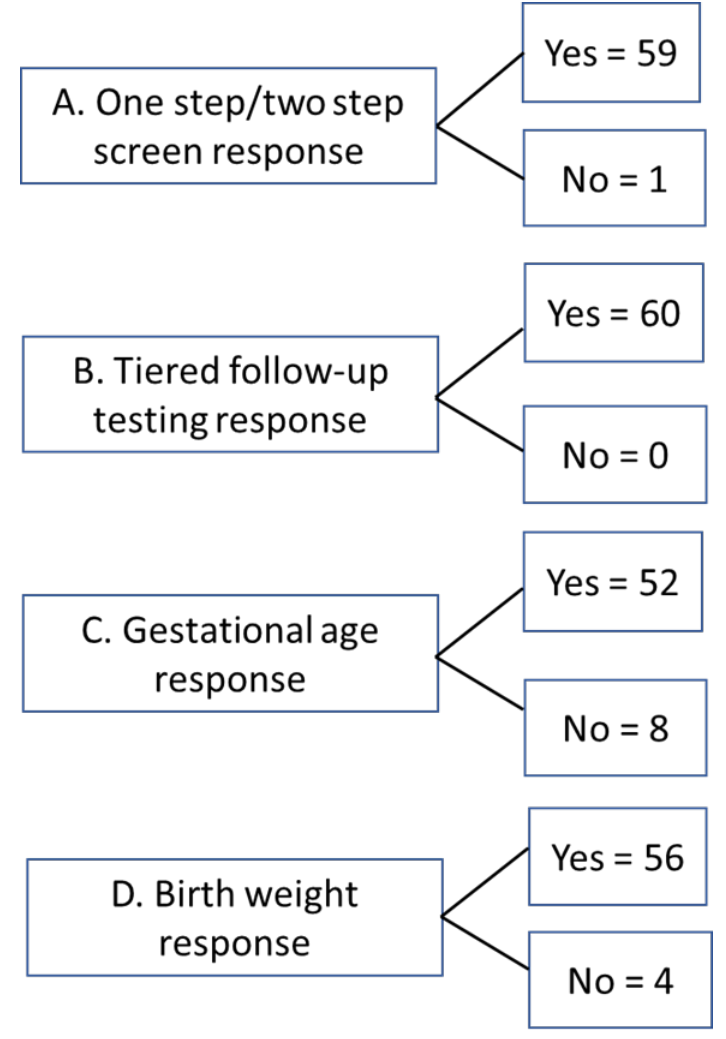
Figure 2. Response rate for survey questions. Overall, sixty responses were received to the survey. Not all questions were answered by all respondents.